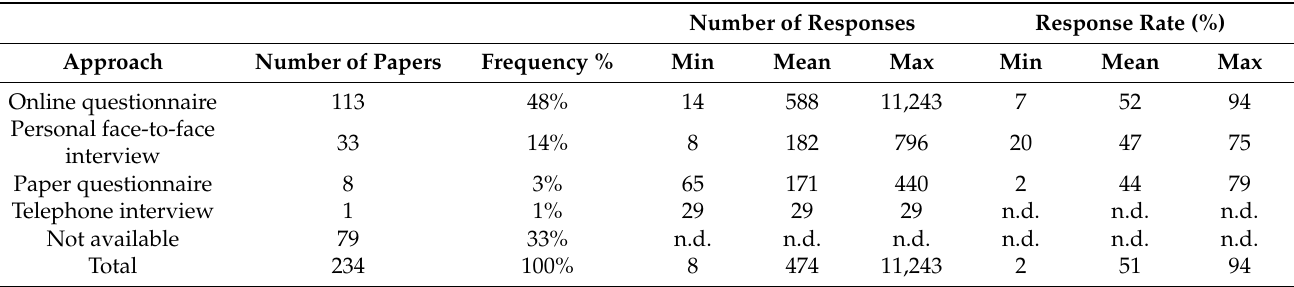
Table 4. Type of approach